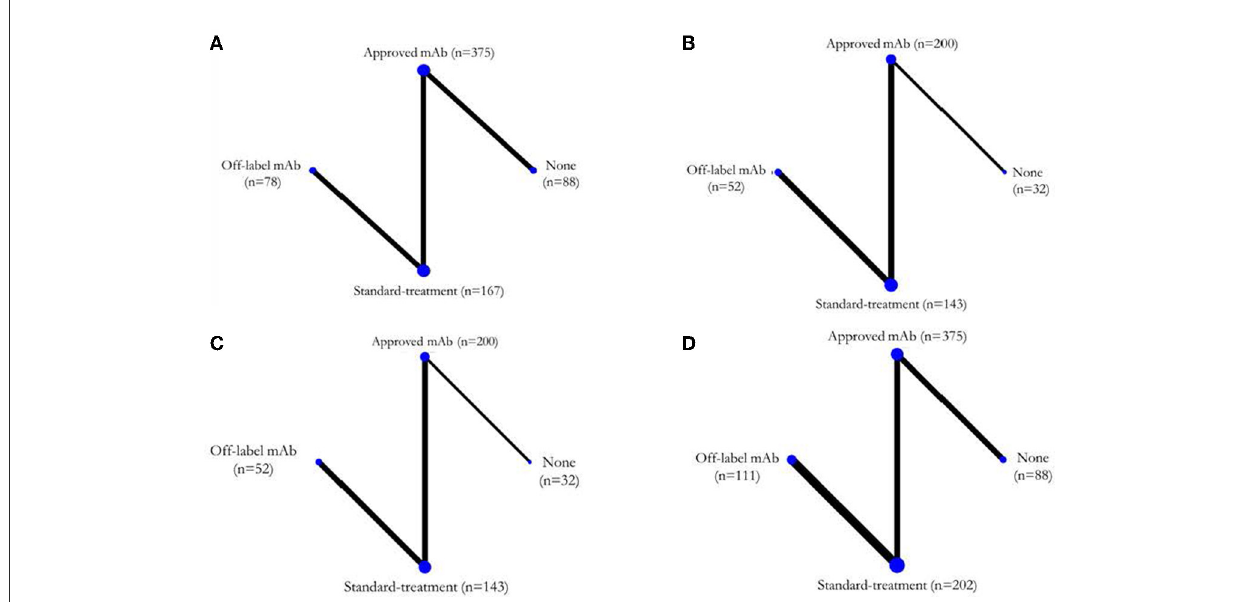
FIGURE2 Network map for each outcome. (A) Time to disease relapse, (B) ARR post-treatment, (C) EDSS changes, and (D) SAEs. ARR, annualized relapse rate; EDSS, expanded disability status score; SAEs, serious adverse events.